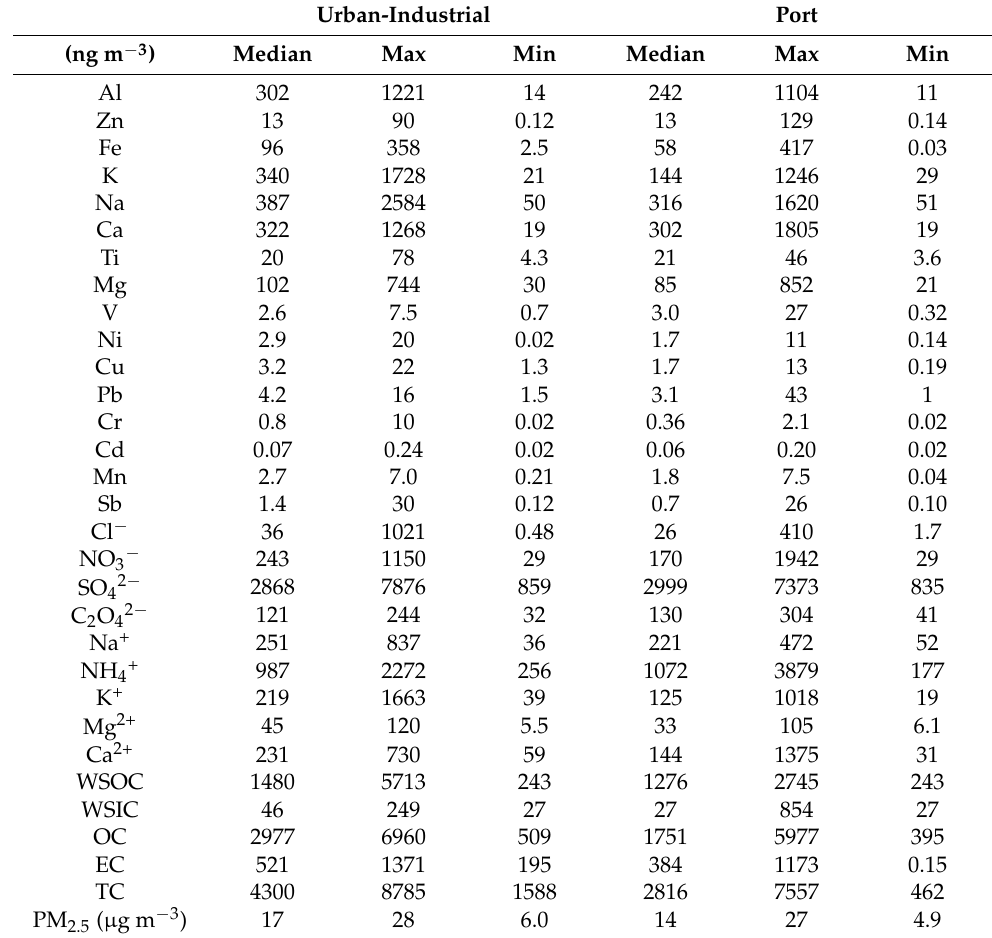
Table 1. Descriptive statistics of all determined parameters. The samples have been grouped for prevalent wind directions in two macro-sectors: Urban-Industrial (i.e., samples collected when the prevalent wind direction was from the city of Brindisi or the industrial area) and Port (i.e., samples collected when the prevalent wind direction was directly from the